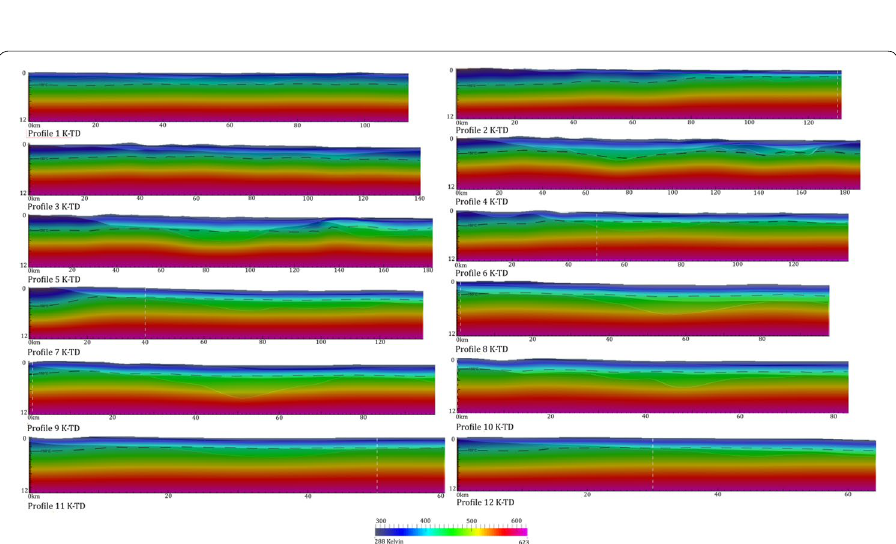
Fig. 9 Temperature-dependent thermal conductivity models for profiles 1–12. Temperature is given in degrees Kelvin (range from 288 to 623 K). K-TD refers to K thermal conductivity and TD Temperature dependent. White dashed lines refer to local geothermal gradients showcased in Fig.